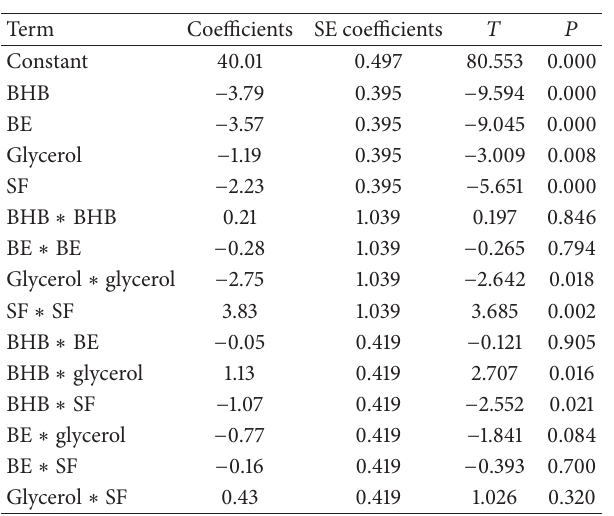
Table 3: Various factors and their interactions.